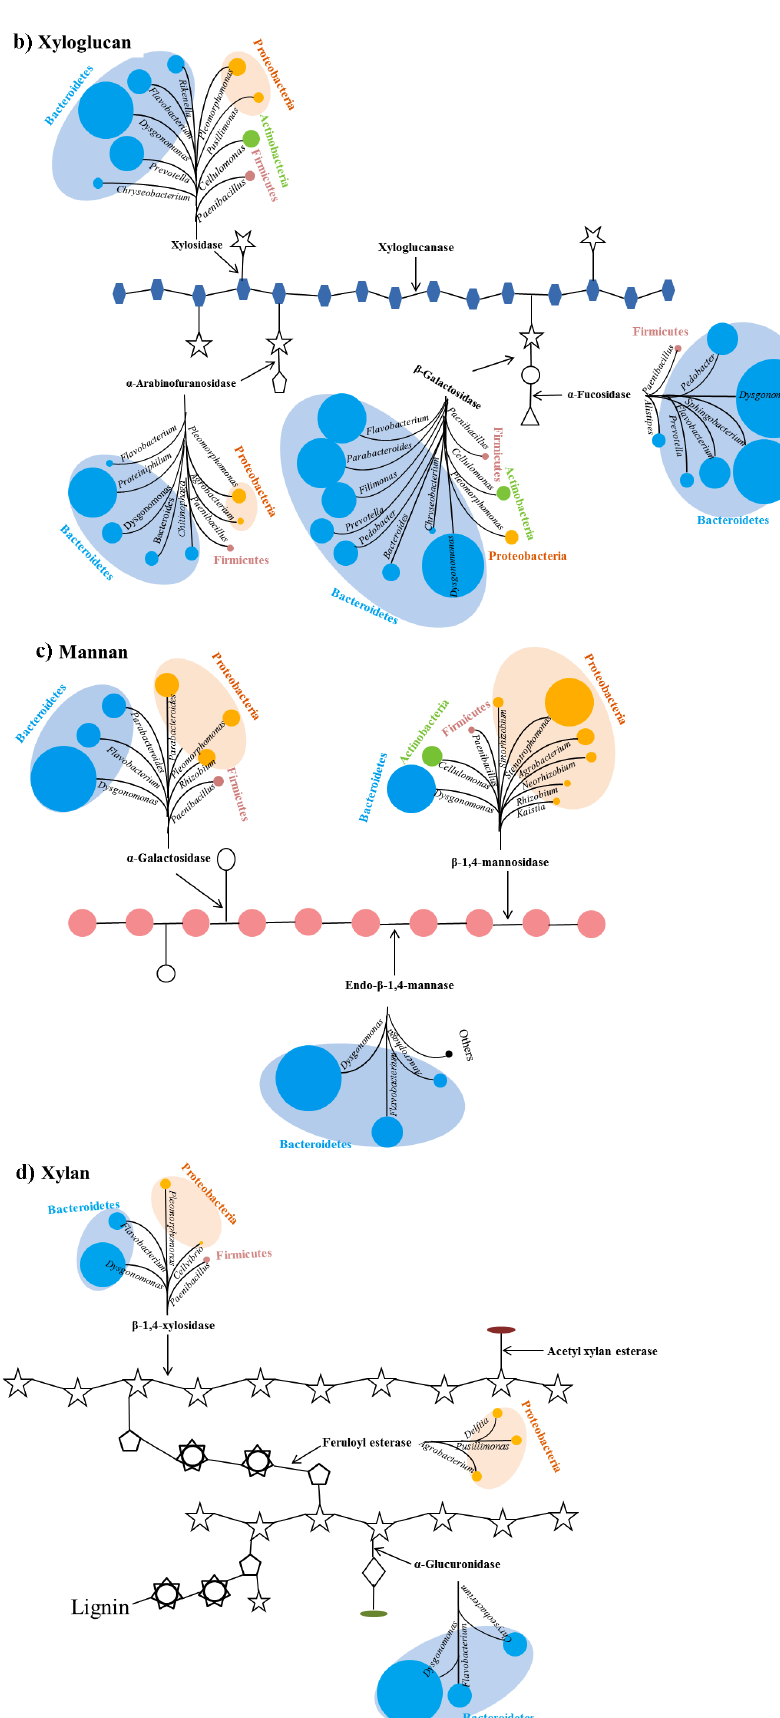
Note: a)–d) represents dominant microorganism degradation for cellulose, Xyloglucan, Mannan and Figure 6. Degradation of lignocellulose-related enzymes in GF-20